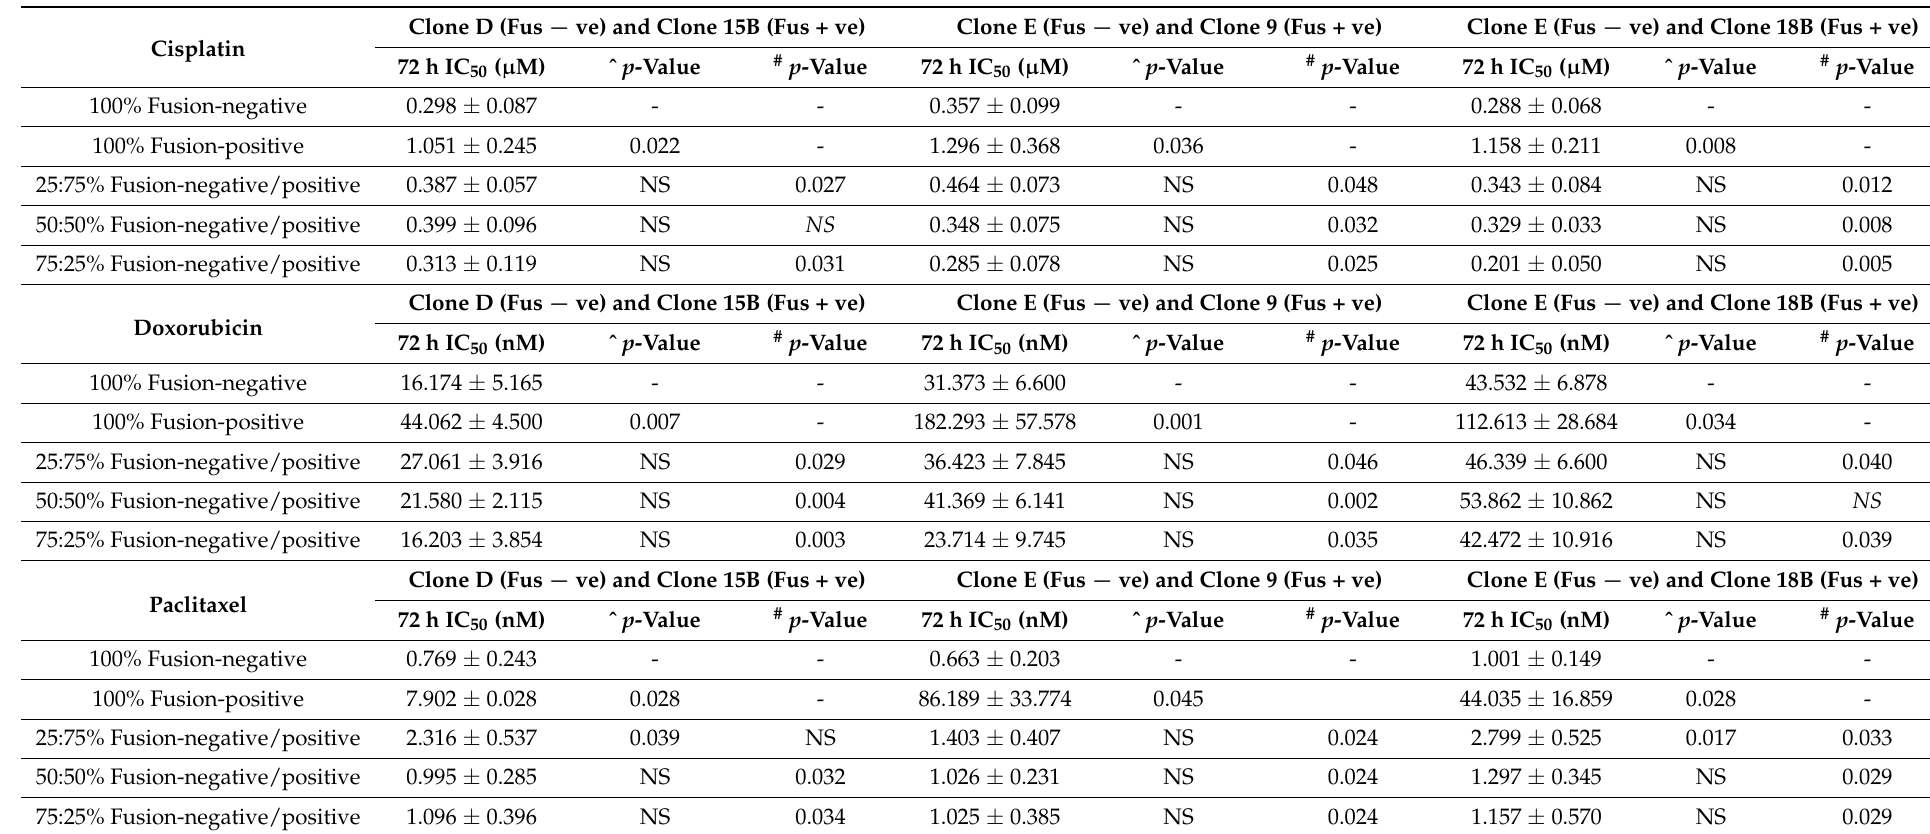
Table 1. Influences of clonal composition in mediating